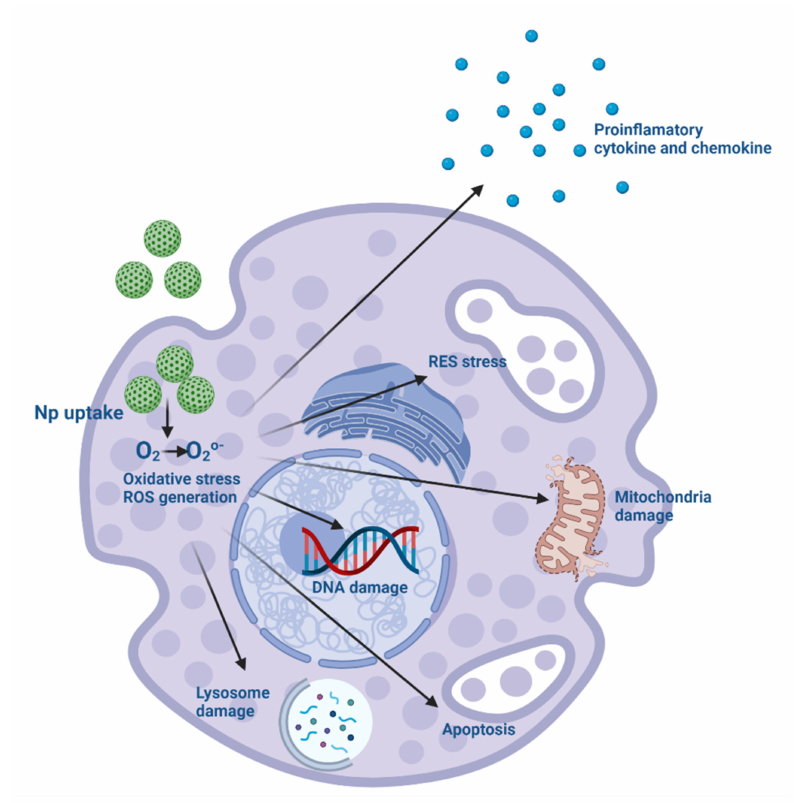
Figure 4. ROS generation caused by NPs, O2 O2o-. Reactive oxygen species (ROS) are natural subproducts of cellular oxidative metabolism that play an important role in modulating cell survival, cell death, differentiation, cell signaling, and production of inflammation-related factors. Altered redox homeostasis leads to damaging oxidative effects on cells mediated by interference with signal- ing mechanisms or biomolecules (proteins, lipids, and nucleic acids). NP-induced ROS generation initiates a sequence of pathological events, including inflammation, fibrosis, genotoxicity, and car- cinogenesis, modulated by the physicochemical characteristics of the particles, such as size, charge, surface area, and chemical structure. This can generate toxicity with the expression of proinflamma- tory cytokines, fibrotic, activation of inflammatory cells (macrophages and neutrophils), which in each NP should be characterized and investigated. The mechanisms vary between particles, and the central cellular mechanism related to ROS production remains unexplained. Most NPs can cause toxicity facilitated by the release of free radicals. Created with BioRender.com (accessed on 10 December